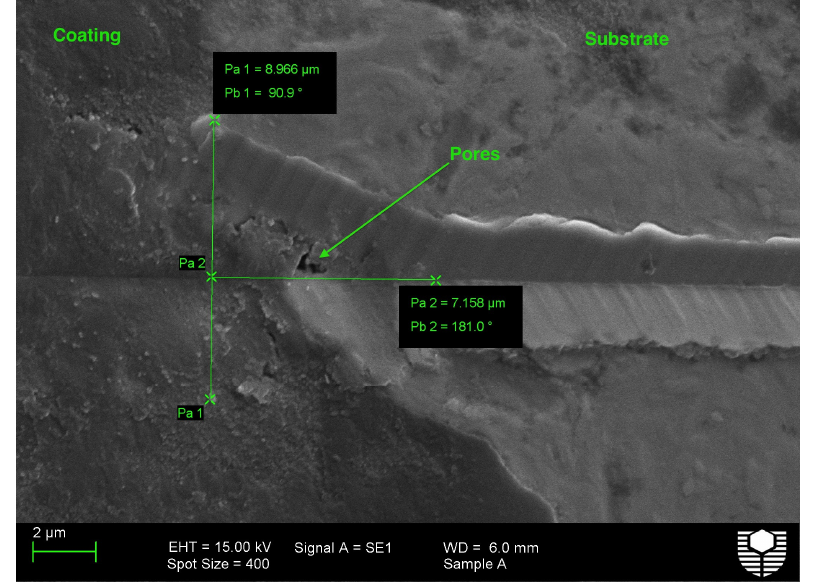
Figure 4. SEM image showing cone formation (coating thickness: 300 m).